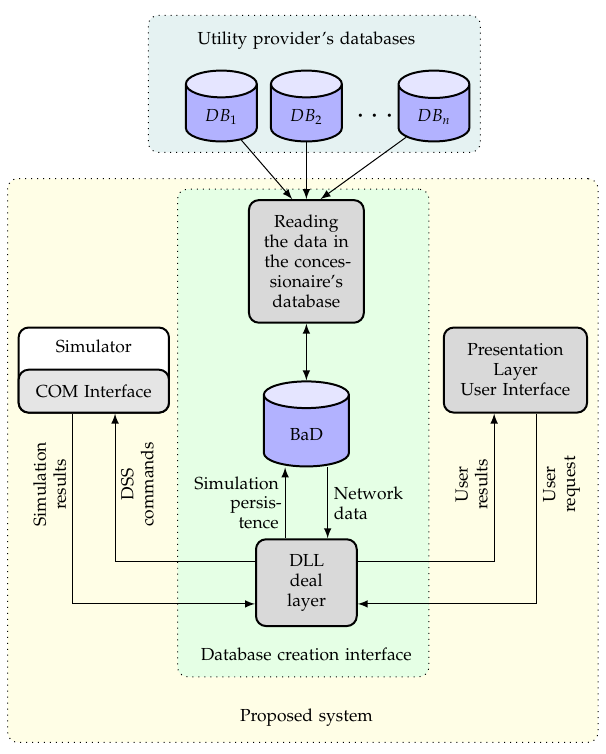
Figure 1. Proposed System